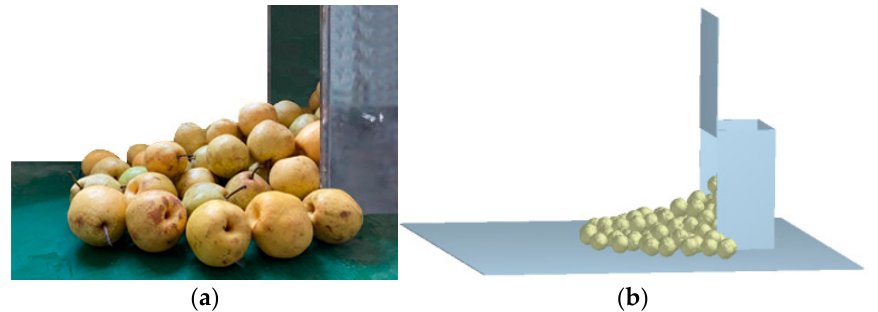
Figure 8. Experiment of pear accumulation angle. Physical experiment ( a ); Simulation